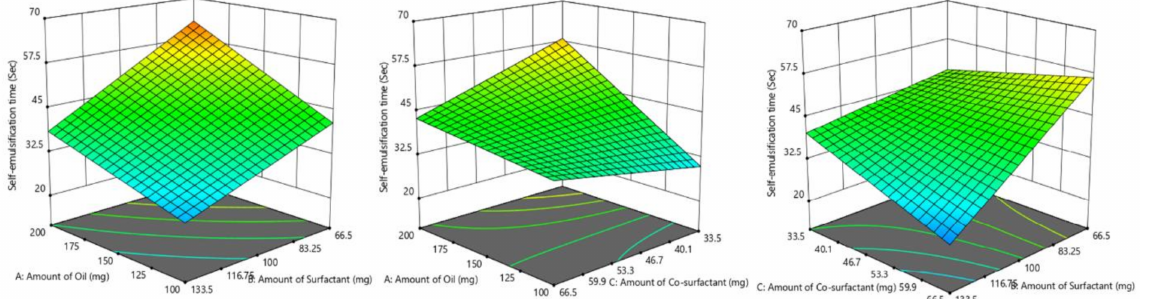
Figure 6. 3D surface plot showing the effect of formulation factors: glycerol triacetate (oil); Tween 80 (surfactant); and PEG 200 (co-surfactant)] on self-emulsification time (SEF; Y 3 ). It was demonstrated that all the prepared batches had self-emulsification times < 1 min and the transparent emulsion was observed, thereby confirming the formation of nanoemul- sion. The selected batch (F4) had the lowest self-emulsification time (31.14 ± 2.67 s, Table 4), which might be probably due to the larger surfactant concentration. Surfactant allows rapid transport of water into globules as it reduces the interfacial force that exists between oil